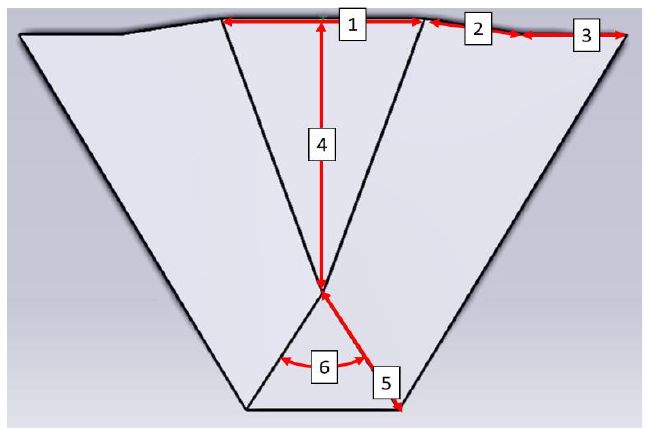
Figure 9. Surfaces of the winged aerial robot and representative parameters: separation between arms ( 1 ), upper arm ( 2 ) and forearm ( 3 ) link lengths, fuselage length ( 4 ), tail length ( 5 ), and wide angle ( 6 ) of the tail.